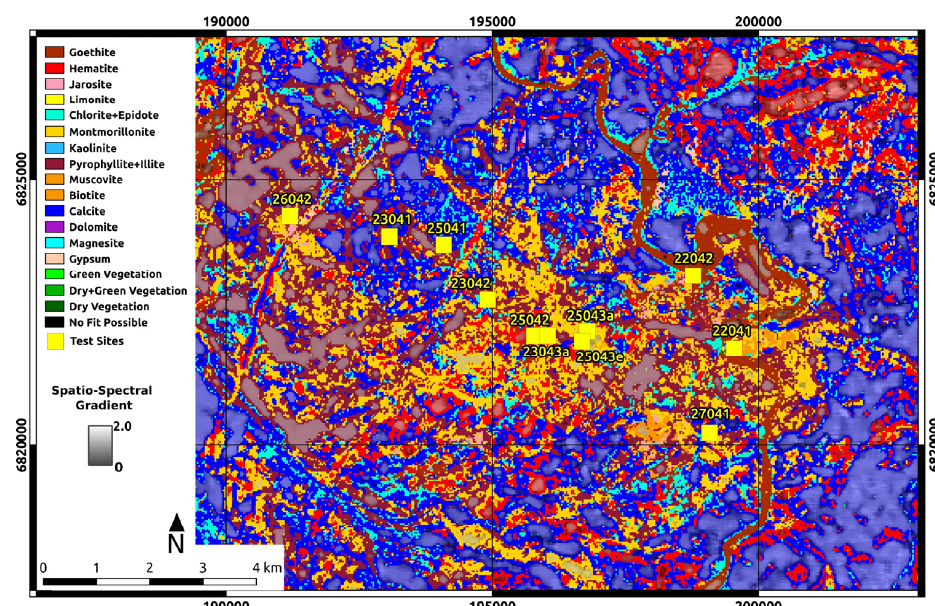
Figure 16. EnGeoMAP 2.0 best fit material map, using sensor dependent absorption depth thresholding, with a semi-transparent overlay of the spatio-spectral gradient using the entries of the USGS digital spectral library [12] as reference spectra.